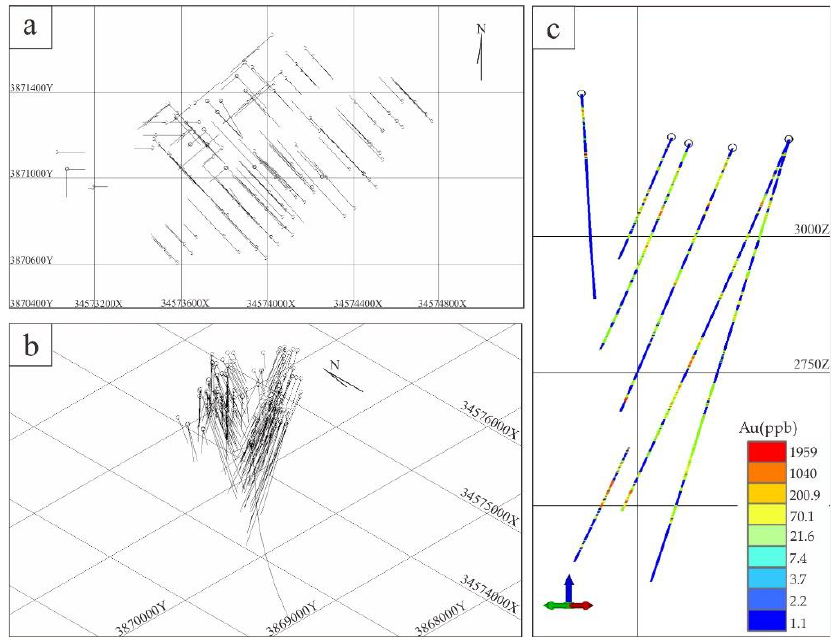
Figure 3. 3D model of Drillings in Zaozigou gold deposit. ( a ) Plan view of drillings distribution. ( b ) Side view of drillings distribution. ( c ) Sample grade distribution of drillings.